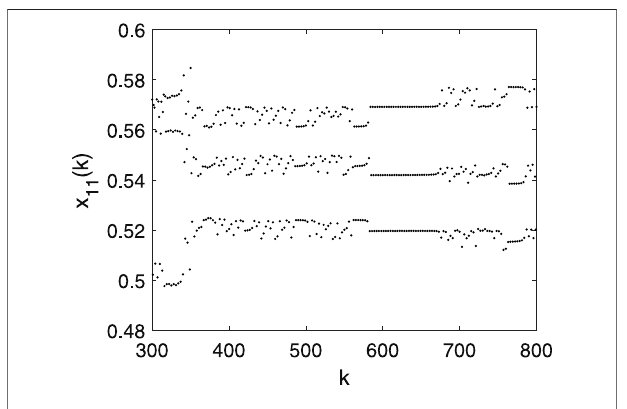
FIGURE 10 | Chaotic bursting in the intermittent behavior of x 11 shown by the multidimensional logistic map with N = 100 for a (cid:2) 1 +